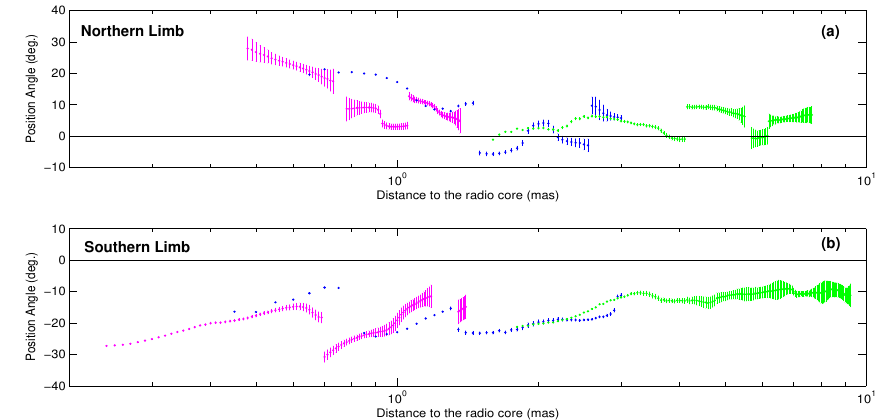
Figure 4. ( a ) Position angles of the northern limb in M87 as functions of core distance d . ( b ) Position angles of the southern limb in M87 as functions of core distance d . The colors represent the measured frequencies, magenta for 86 GHz, blue for 43 GHz and green for 22 GHz. The uncertainty of PA is estimated as 20 ◦ in which 20 ◦ is a typical width of the jet limb, and SNR is the ratio between the intensity peak and the σ of images. only peaks with intensity above 5 σ are presented to make sure the result is